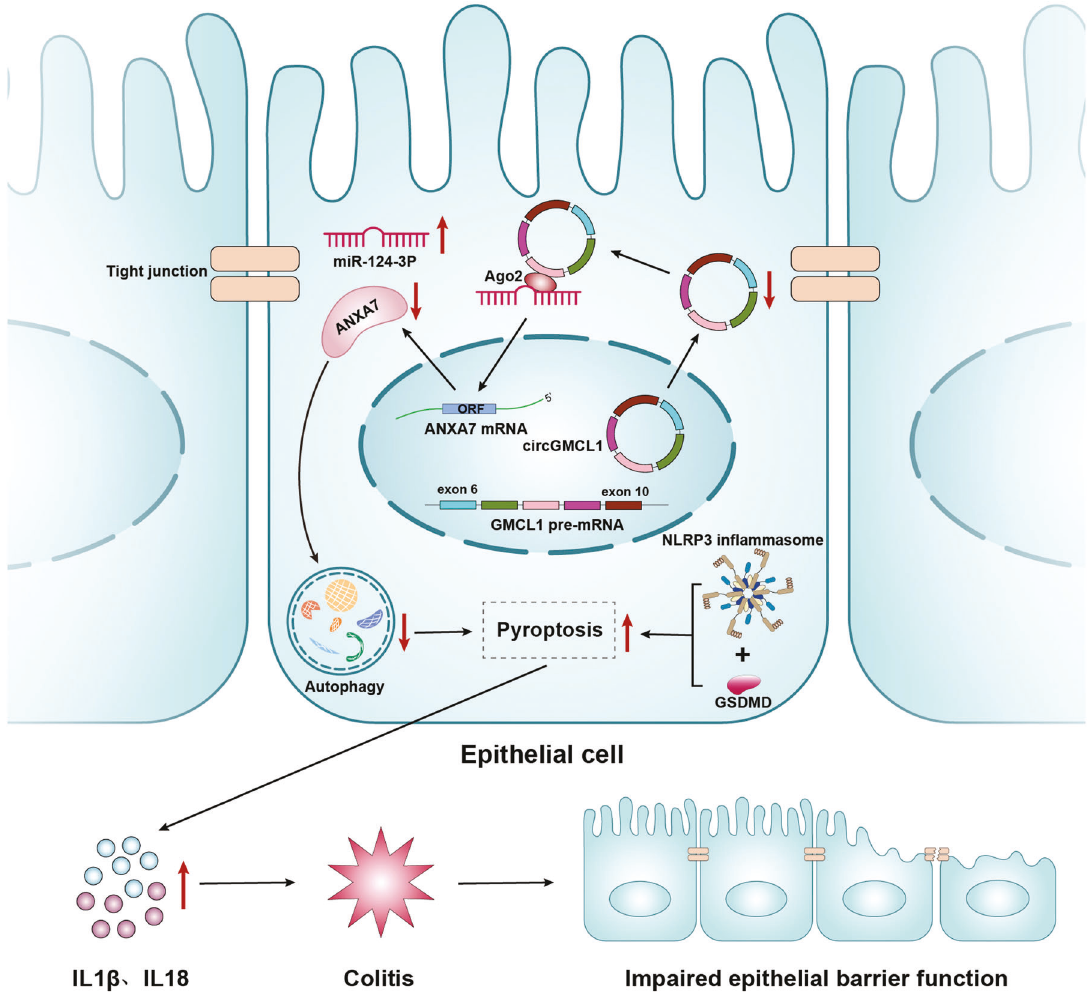
Fig. 8 A schematic diagram of the biological function of circGMCL1 in Crohn ’ s colitis. The downregulation of circGMCL1 lowered ANXA7 expression by sponging miR-124-3p, thereby decreasing autophagy in epithelial cells and increasing NLRP3 in fl ammasome-mediated pyroptosis and release of proin fl ammatory cytokines. This resulted in aggravation of colitis and damage to the intestinal barrier function. ANXA7, annexin 7, ORF Open Reading Frame, IL